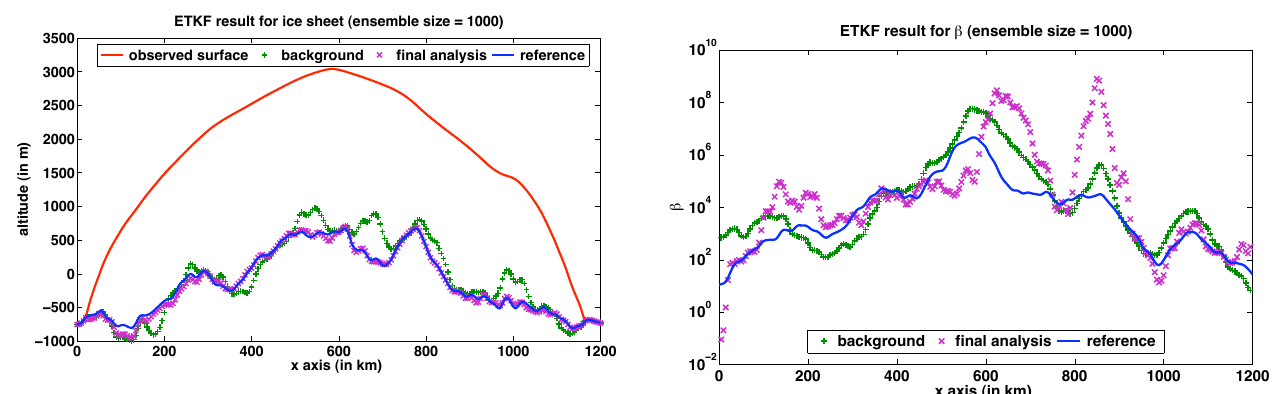
Fig. 10. β parameter after 20years of the 1000-member ETKF. The analysis (purple x) is compared to the background (green crosses) and the reference (blue). Values of β above 10 5 are all equivalent in terms of sliding velocity. Similarly, β is meaningless where there is no ice (close to boundaries).